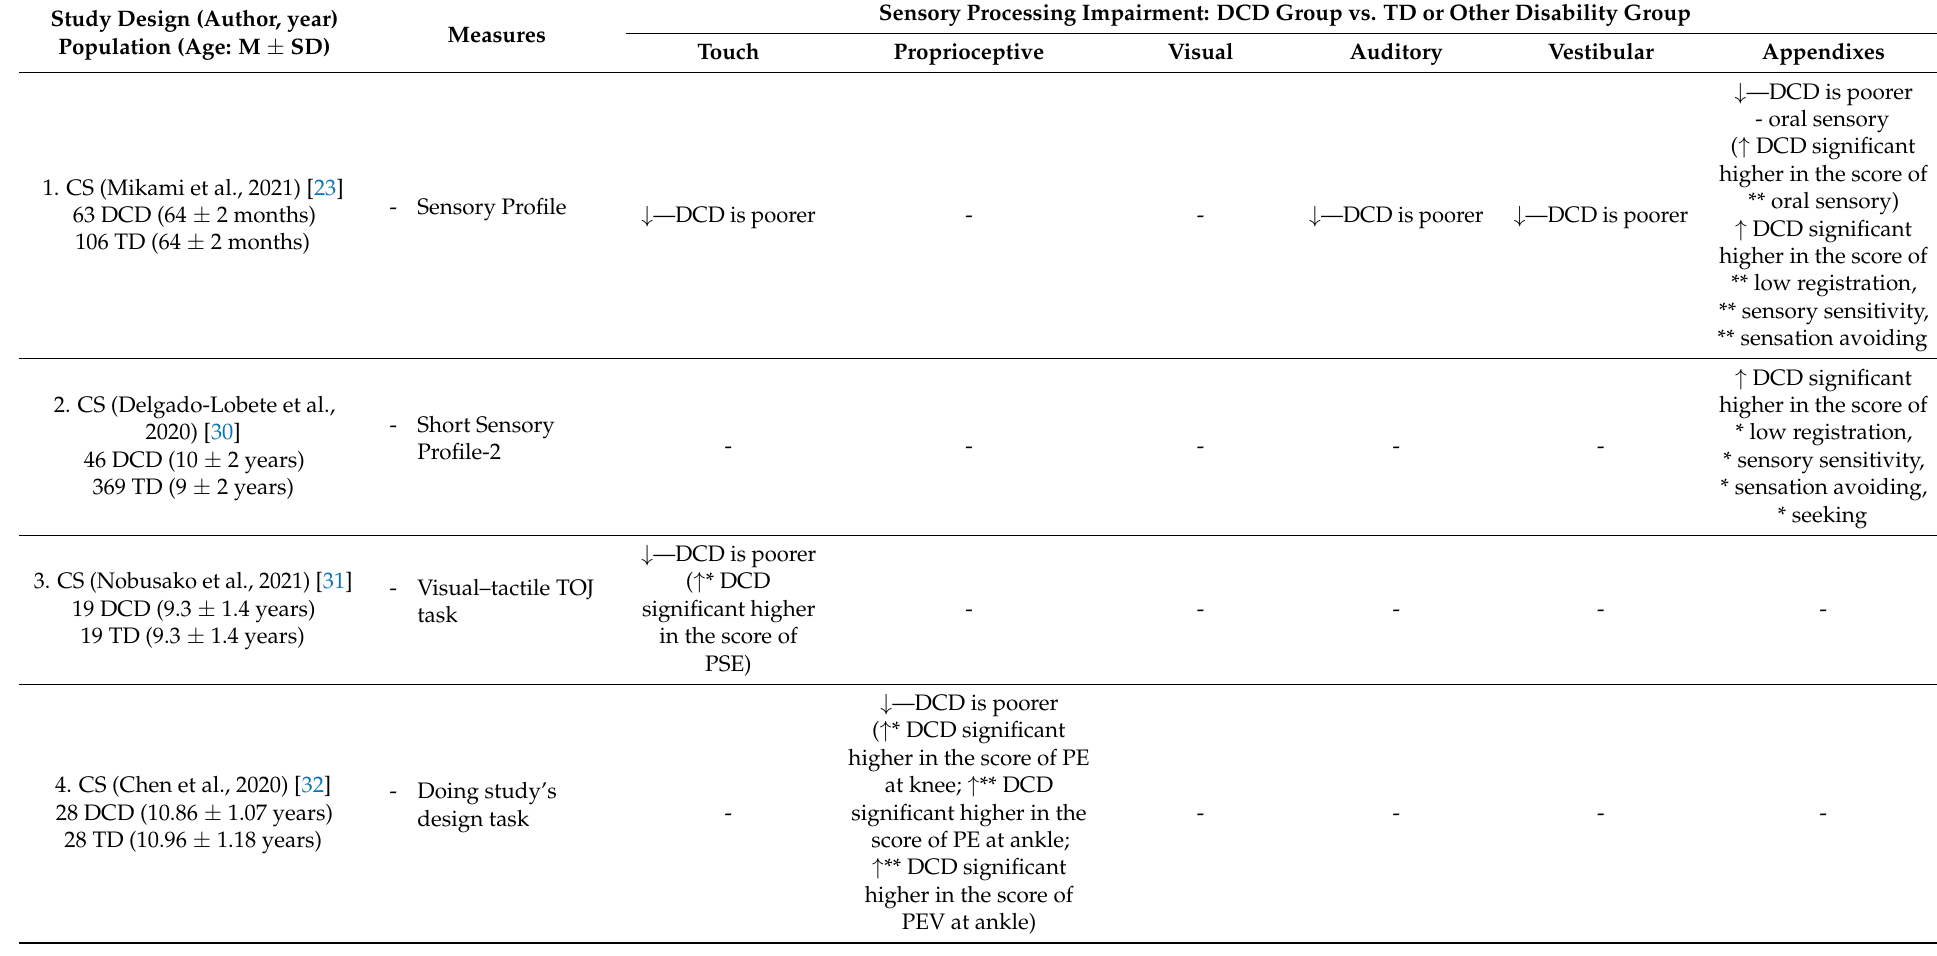
Table 2. Sensory processing impairment in children with and without developmental coordination disorder